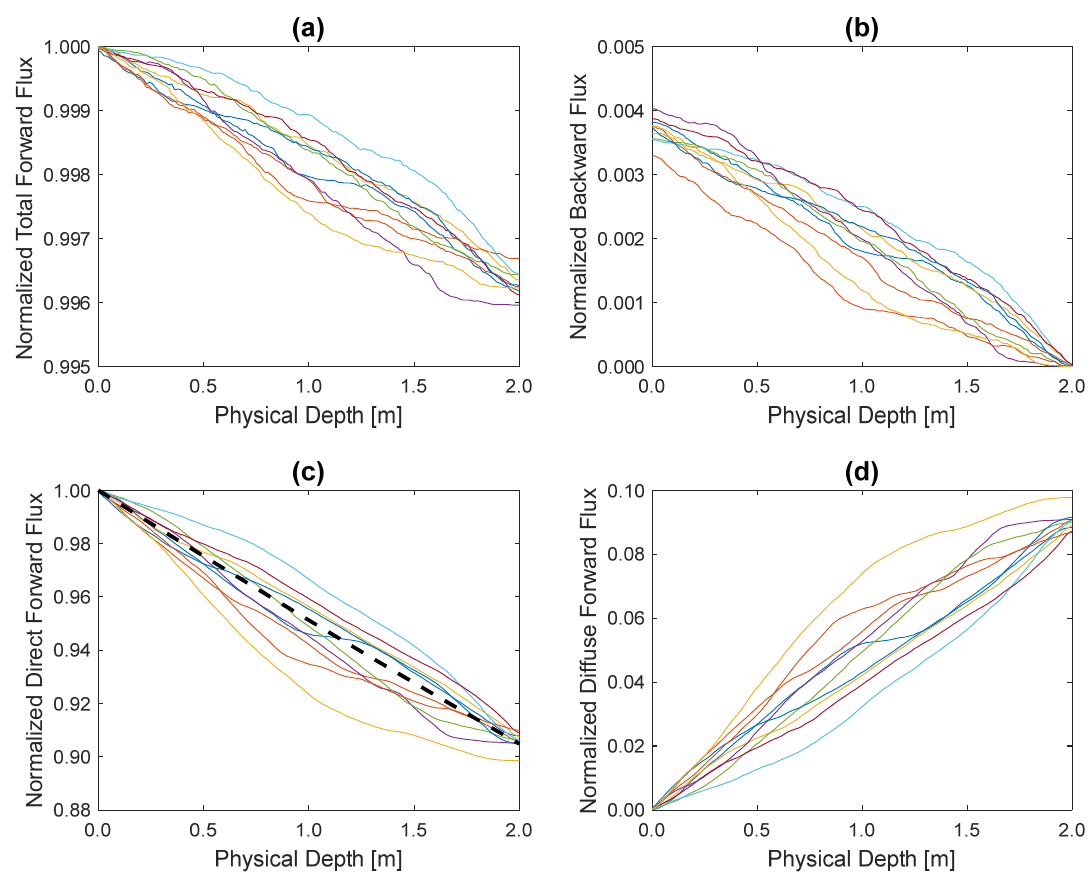
Figure 4. Depth-dependent flux curves for ten LES polydisperse spatial distributions, chosen to be very near an expected total optical thickness of 0.1. Spatial positions come directly from LES output records. Panels ( a )–( d ) show the four flux components including total forward, backward, direct forward and diffuse forward (respectively). An additional dashed curve was added to panel c to indicate Beer–Lambert law direct transmission, for comparative purposes. Theoretical predictions for the other panels are difficult due to the complex nature of our simulations (e.g., periodic boundary conditions, lack of a true plane parallel scenario, etc.). See [12] for a comparison of the Monte Carlo approach to two-stream theory and the accompanying discussion. It should be noted that convergence at the end of the optical path is expected, and is largely predetermined, because of preconditioning the LES distribution selection based on expected optical thickness τ = 0.1 ± 0.001 .